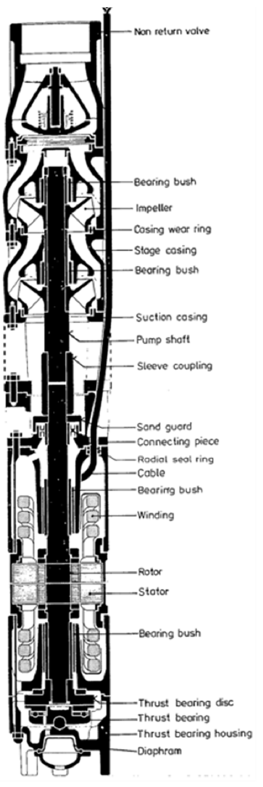
Figure 7. Submersible motor pump of KSB. Minerals 2022 , 12 , x